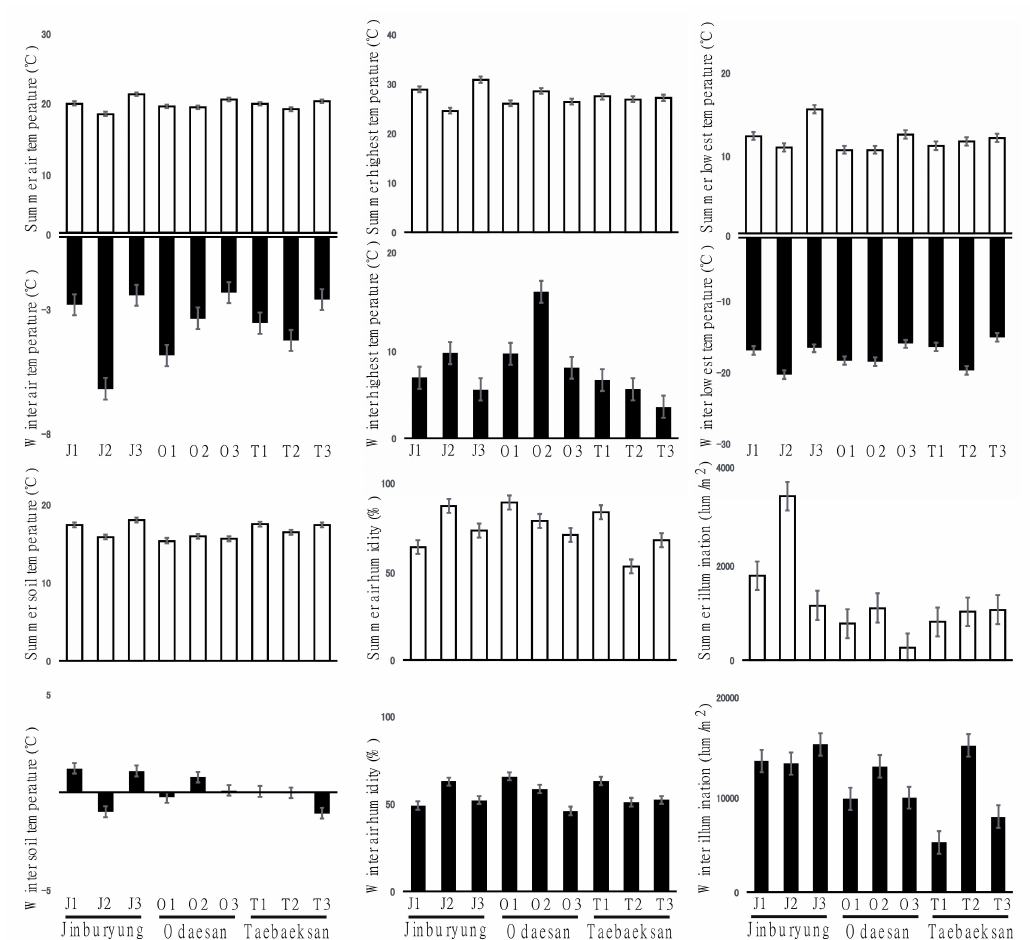
Figure A1. Temporal changes in environmental factors in the study sites on the Baekdudaegan Mountain Range, Korea. White and black bars refer to summer and winter environmental factors,